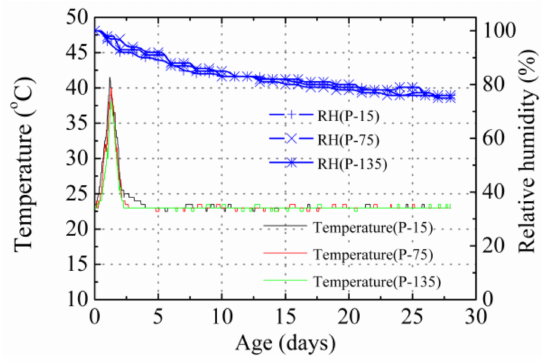
Figure 4. Temperature and RH in the P specimens.